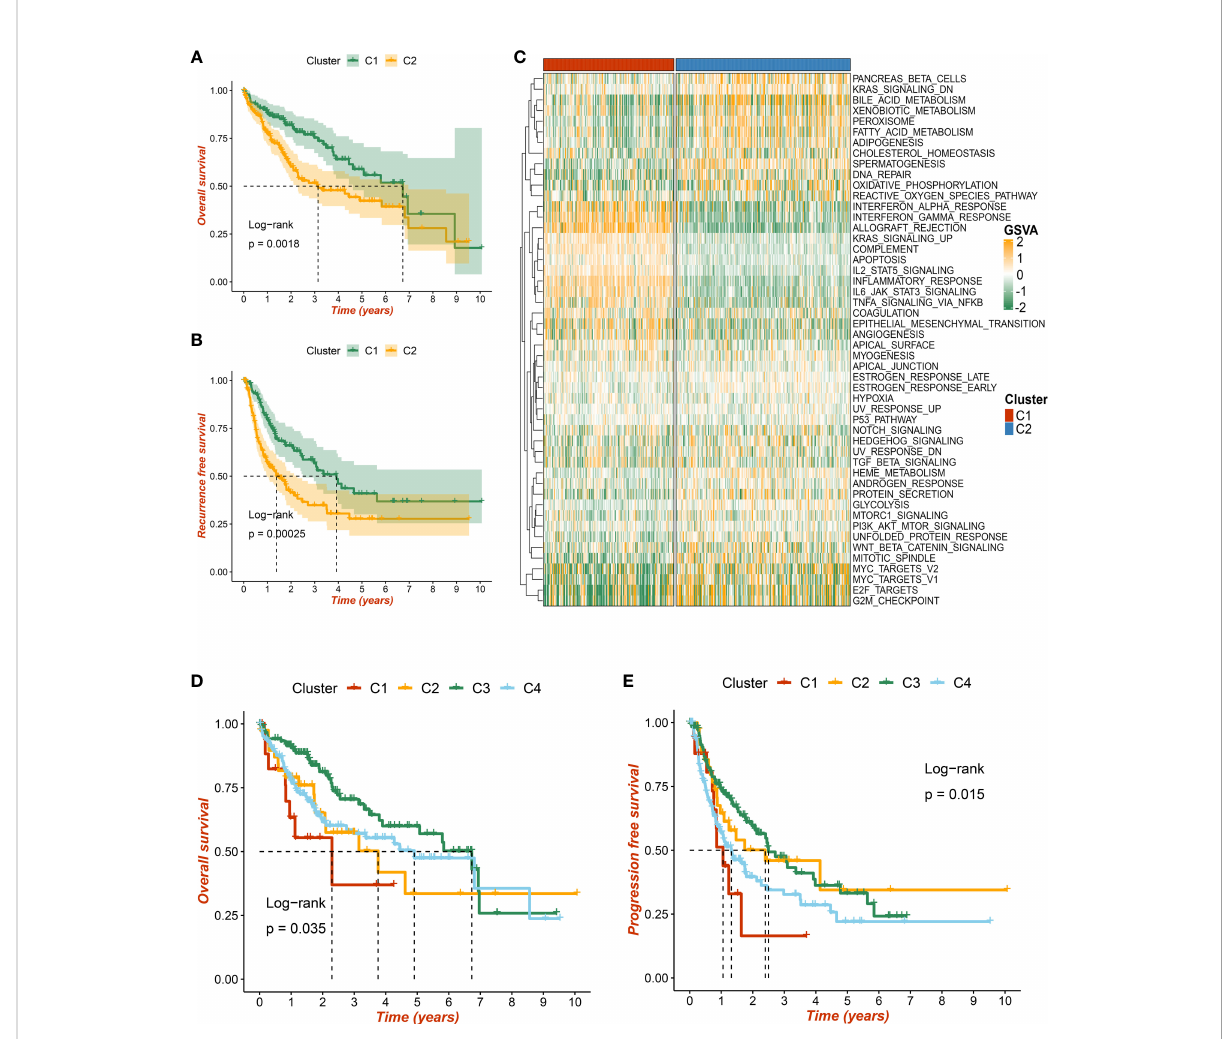
FIGURE 5 The prognostic signi fi cance of necroptosis subtypes. (A) Kaplan – Meier curves of overall survival (OS) according to the necroptosis subtypes in TCGA-LIHC dataset. (B) Kaplan – Meier curves of recurrence-free survival (RFS) according to the necroptosis subtypes in TCGA-LIHC dataset. (C) Heatmap of 50 Hallmark gene sets among three clusters using the gene set variation analysis (GSVA) algorithm. (D, E) Based on previous immune subtypes, Kaplan – Meier curves of OS and progression-free survival (PFS) according to different subtypes,